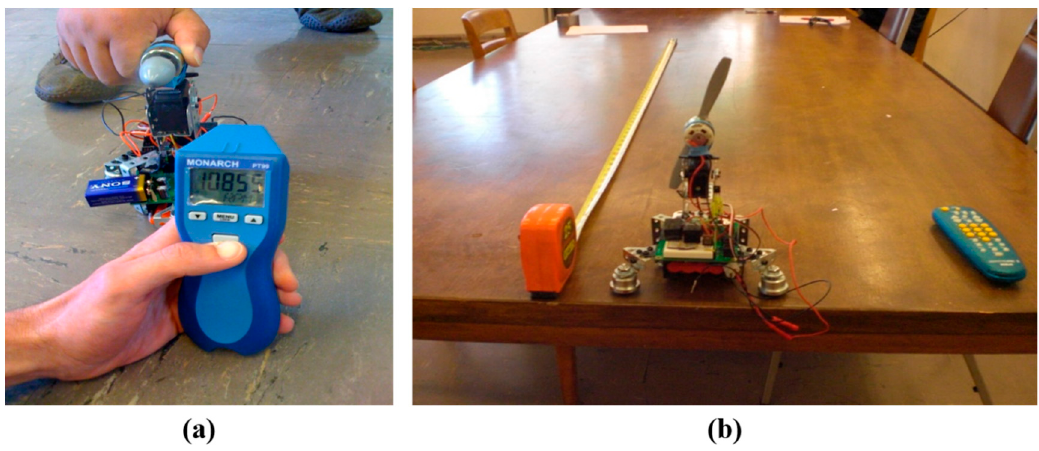
Figure 2. ( a ) Revolutions per minute (RPM) Measurements by Tachometer; ( b ) Speed testing of the vehicle.